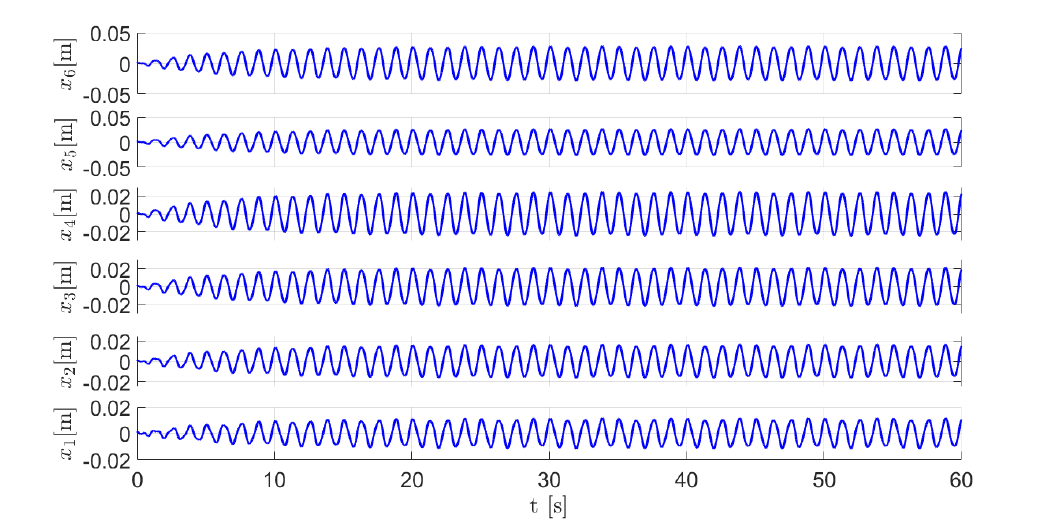
Figure 6. Dynamic response of the primary system without pendulum absorber (Tuned Mass Damper